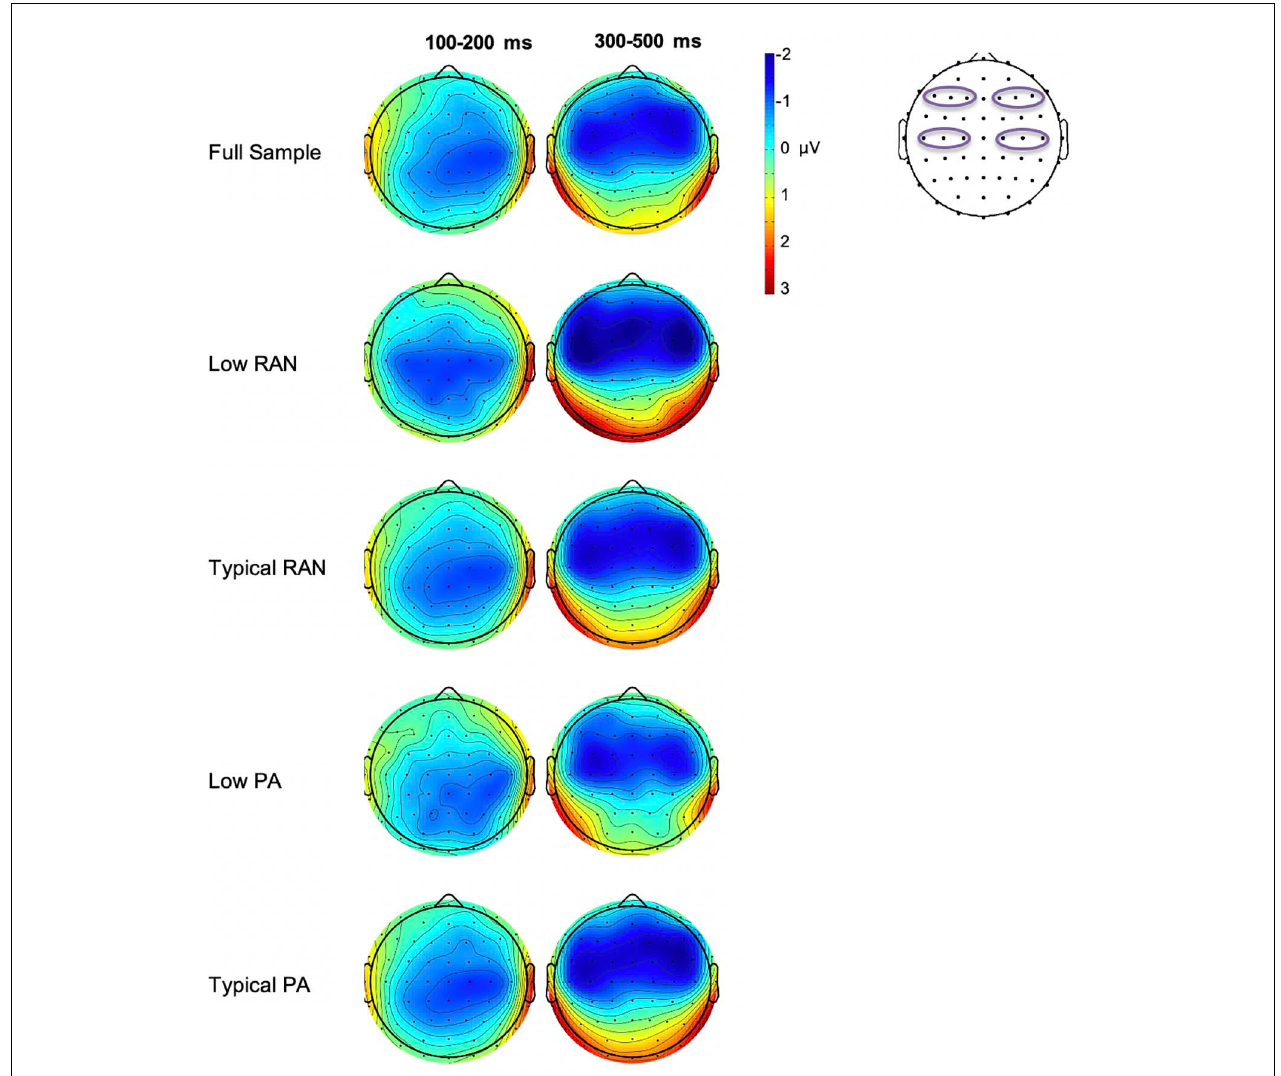
FIGURE 3 | Whole group and subgroup average scalp voltage maps of the MMN difference wave mean amplitude for early (100–200 ms) and late (300–500 ms) time windows. Electrodes used in analysis are outlined on the scalp diagram on the right. Note that there is a large overlap in the participants in the Typical PA and RAN groups ( n = 84 that are included in both), which yields similar